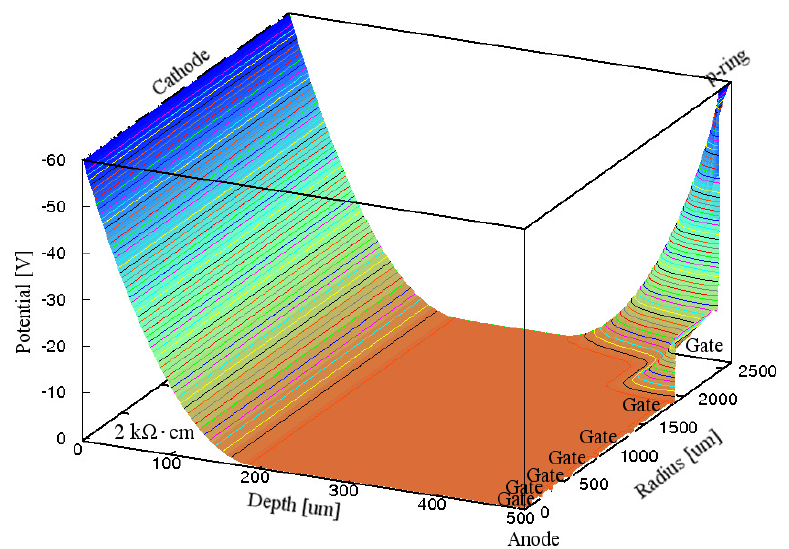
Figure 3. Simulated electric potential distribution in the Si substrate inside the p-ring of a 0 . 5 -mm-thick GSDD with R of 3 . 5 mm and ρ of 2 k Ω · cm for Gate A. A reverse bias chip Si voltage of − 60 V was applied to the cathode, p-ring, and seven gates. Equipotential lines are shown at 1 V